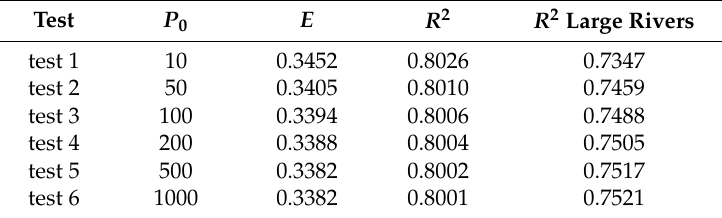
Table 1. Sensitivity analysis of the initial population P 0